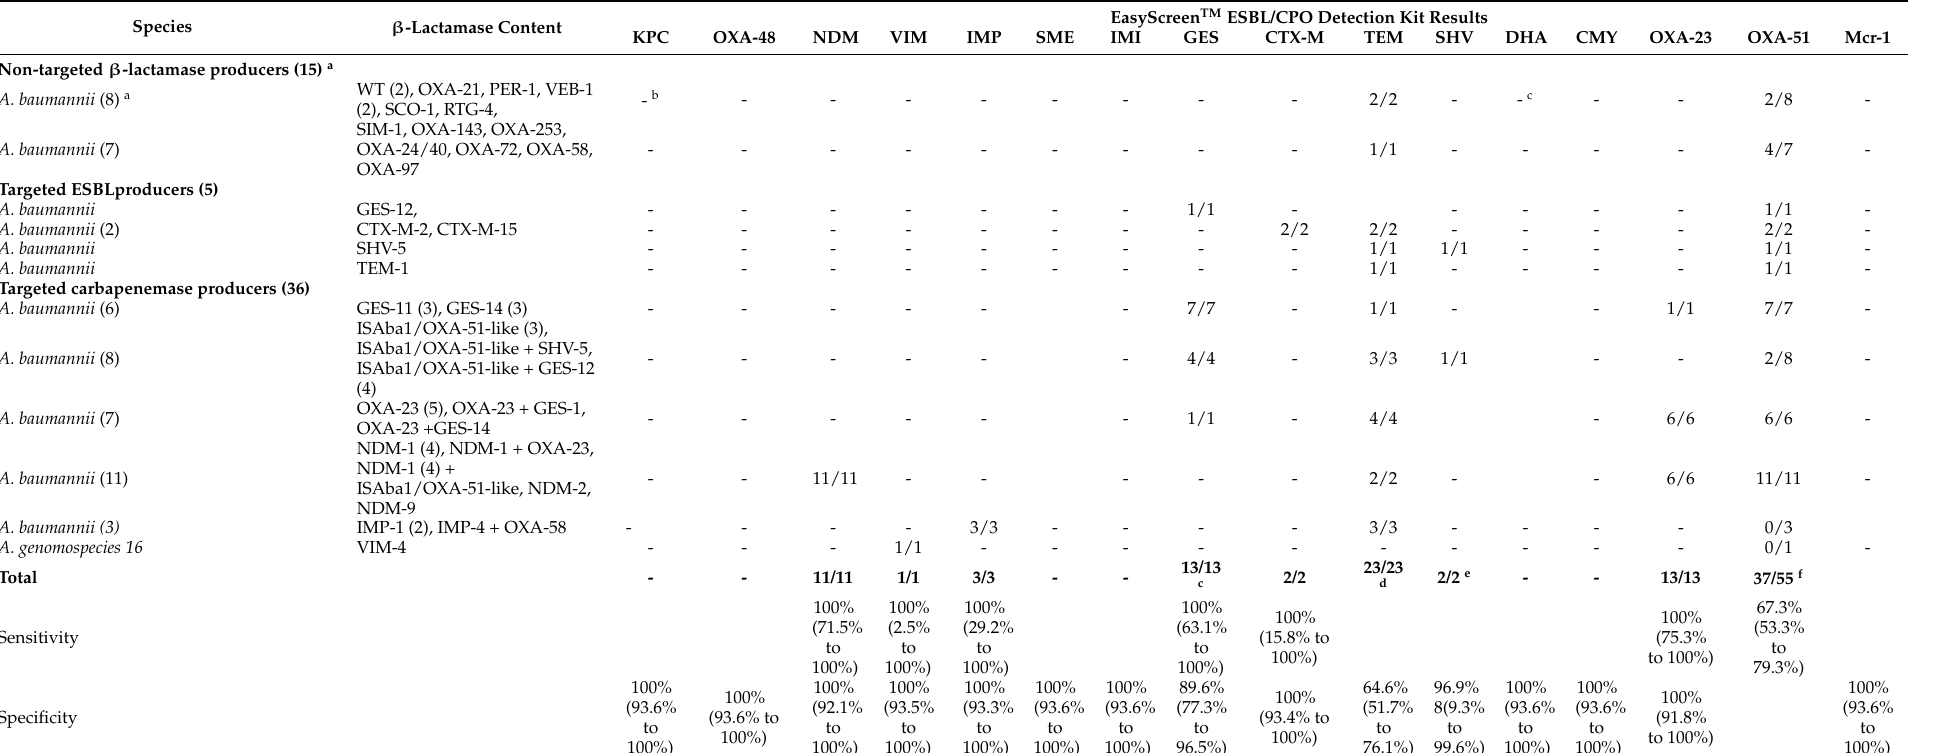
Table 4. Global performances of the EasyScreen TM ESBL/CPO Detection Kit on Acinetobacter spp. (n =